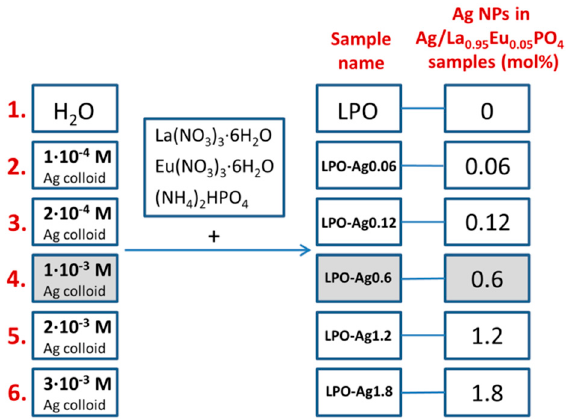
Figure 1. Marking of the La 0.95 Eu 0.05 PO 4 (LPO) samples with different concentrations of Ag nanoparticles (NPs) .